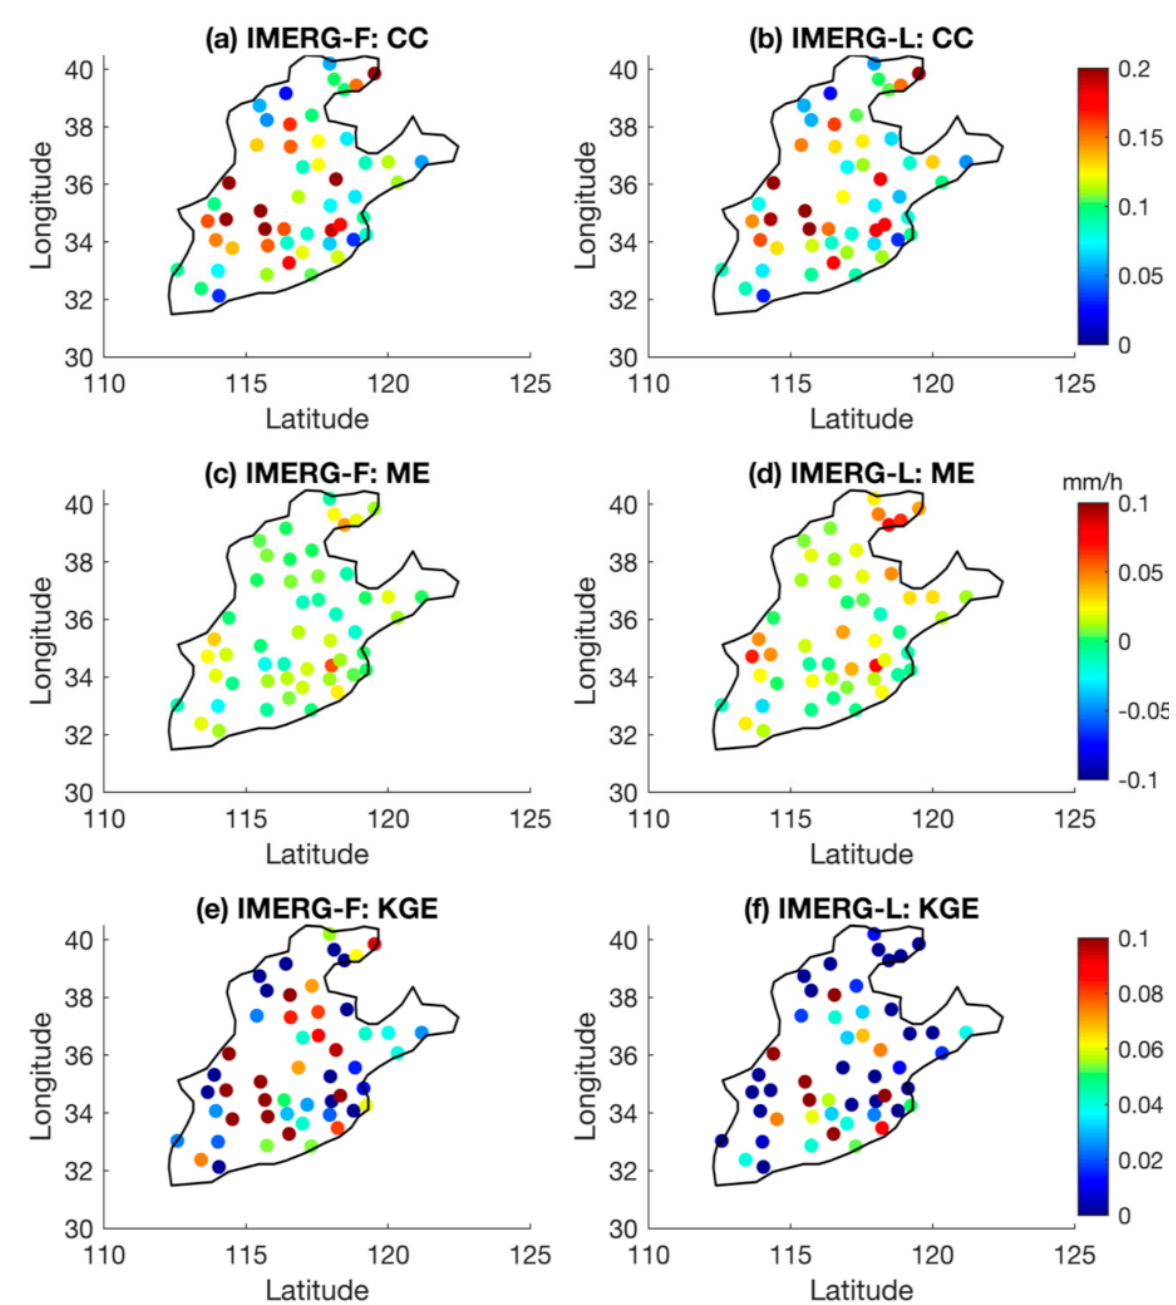
Figure 3. The distributions of CC, ME, and KGE for the IMERG-F and IMERG-L precipitation products at the hourly